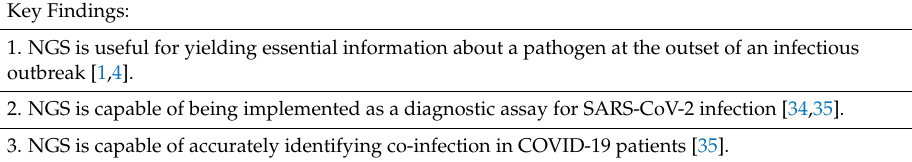
A table comparing currently employed NGS methods—short read: Illumina, Ion